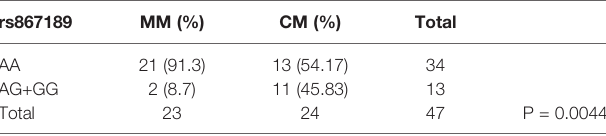
TABLE 4 | The ratio of rs867186 genotype-AA versus -AG and -GG in MM and